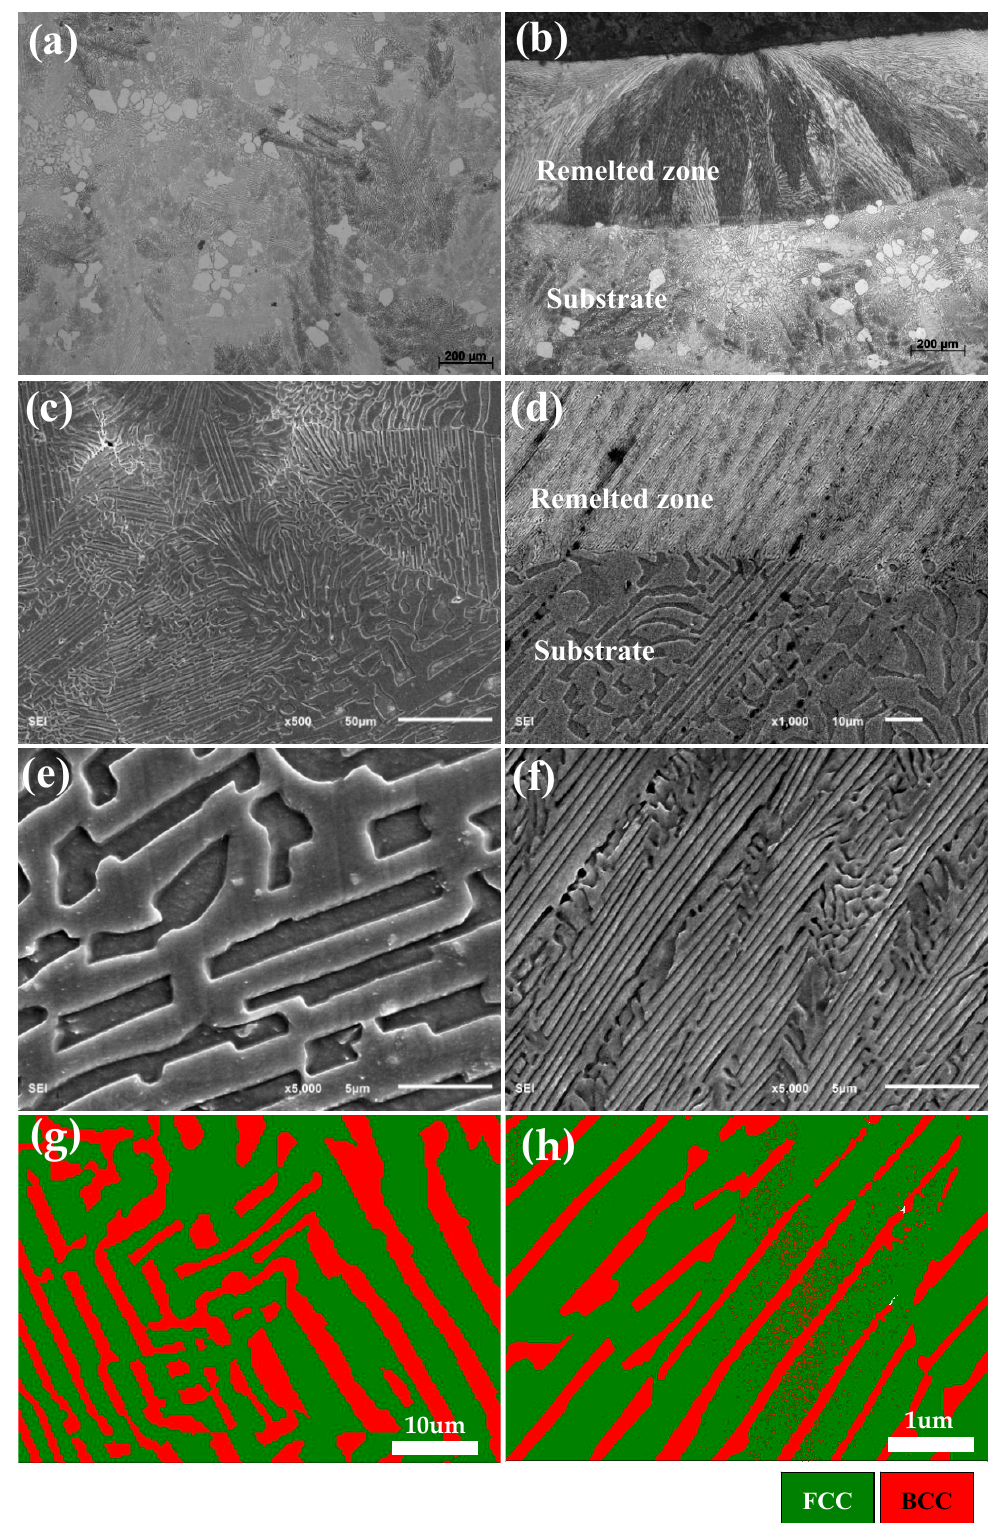
Figure 2. OM images of AlCoCrFeNi 2.1 HEA: ( a ) as-cast; ( b ) LSRed. SEM images of the AlCoCrFeNi 2.1 HEA: ( c ) low magnification of cast state; ( d ) remelted layer cross-sections; ( e ) high magnification of cast state; ( f ) high magnification of remelted zone. EBSD phase maps of: ( g ) cast AlCoCrFeNi 2.1 HEA; ( h ) remelted